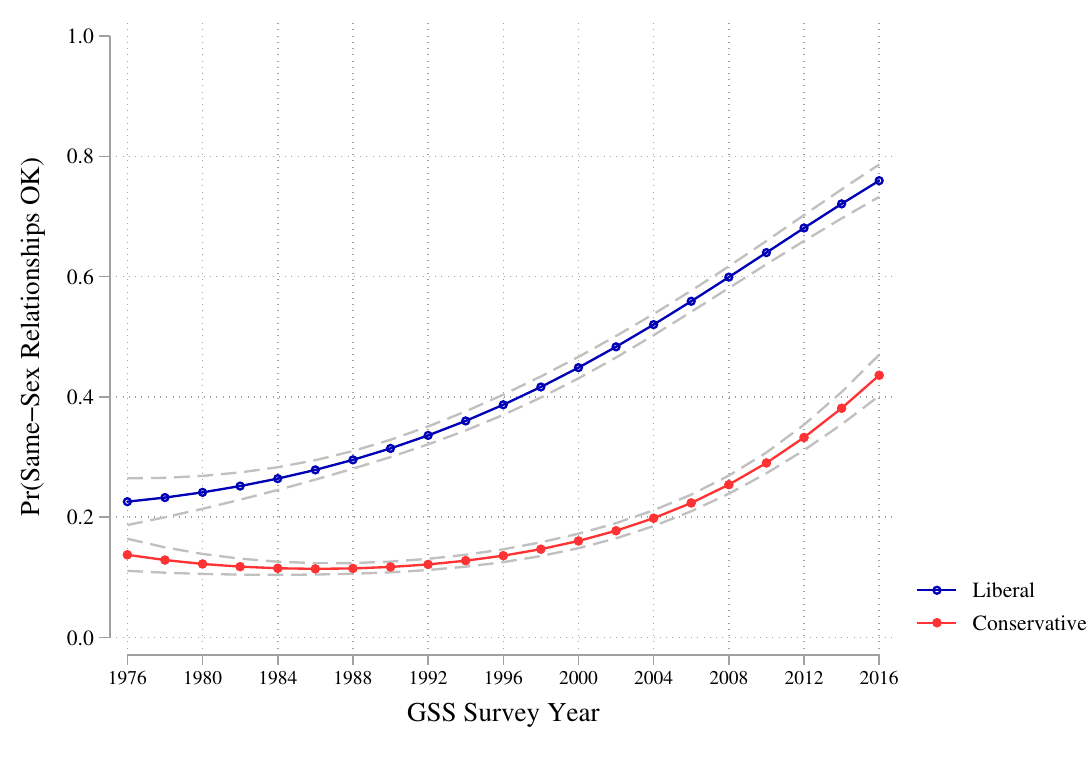
Figure 15: Probability of viewing same-sex relationships as acceptable by political views and survey year: interaction effect between political views and